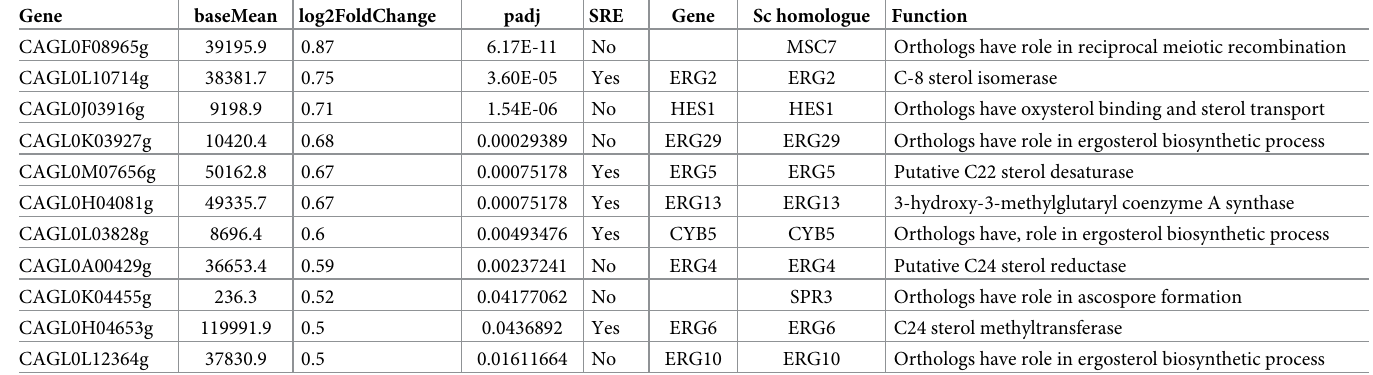
Table 2. Genes induced by log2 of 0.5 or greater in the presence of the G898D UPC2A . RNA-seq was used to compare the levels of transcripts produced in the presence of the G898D UPC2A allele and the ratio of these mRNA levels/those seen in the presence of wild-type UPC2A presented as log2 Fold Change. Gene baseMean